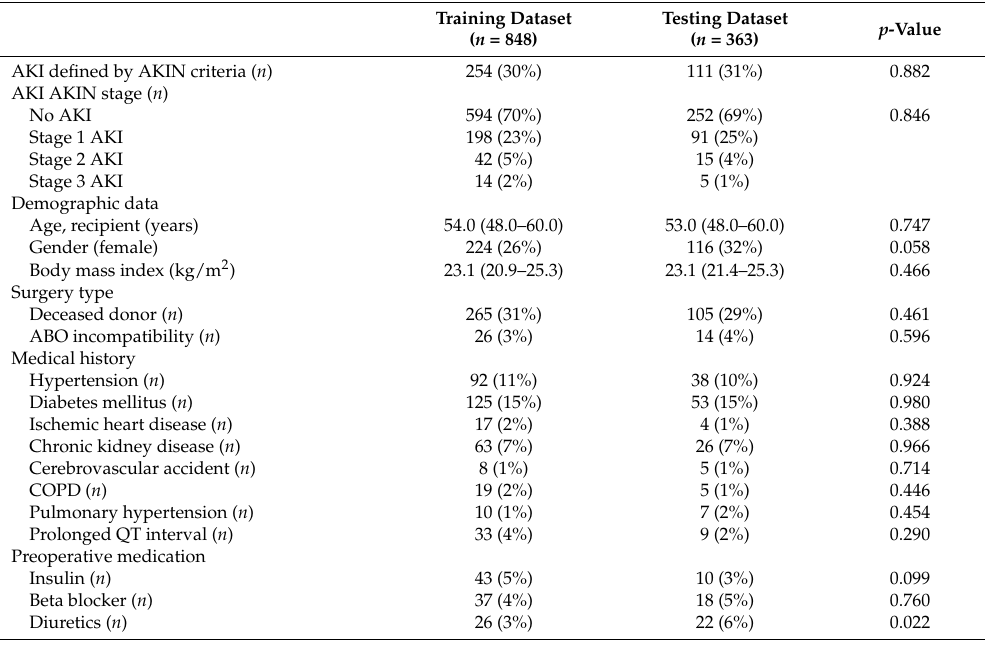
Table 1. Patient characteristics in this